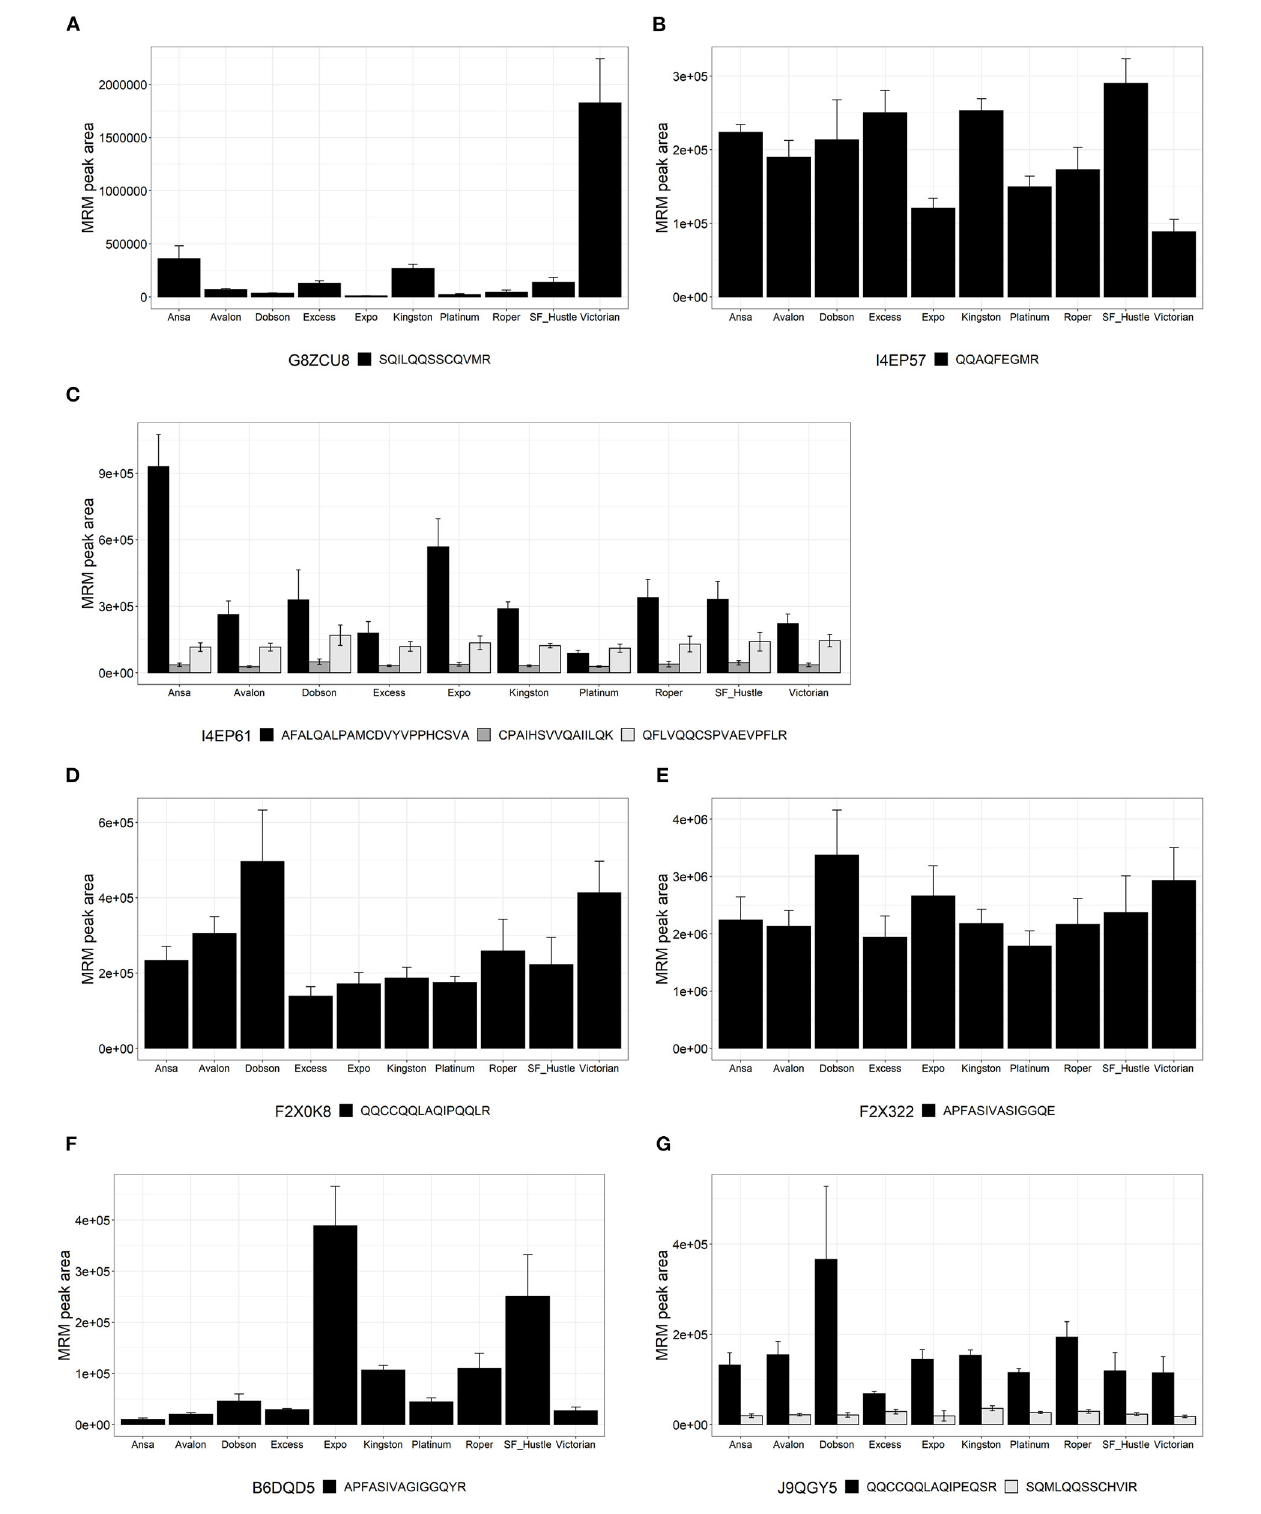
FIGURE 3 | Relative quantitation expressed as multiple reaction monitoring (MRM) peak area for peptides from proteins of the family PF13016 across 10 cultivars of Lolium perenne . Data are presented as the mean ± SD ( n = 3) with one to three peptides from each protein. (A) Avenin protein (G8ZCU8); (B) Avenin (I4EP57); (C) Avenin (I4EP61); (D) Gamma-gliadin (F2X0K8); (E) Gamma-gliadin (F2X322); (F) Gamma-gliadin (B6DQD5); and (G) LMW-glutenin (J9QGY5).